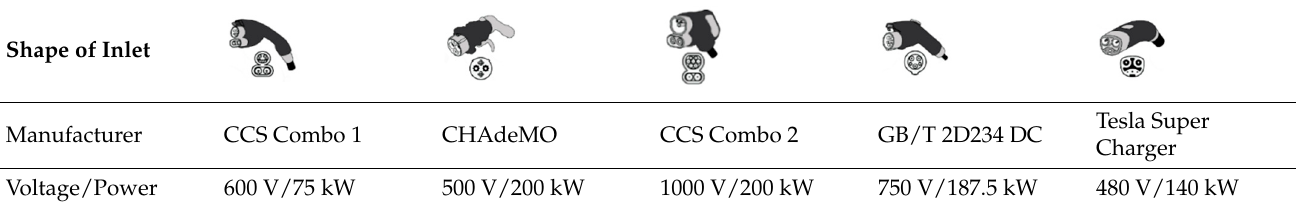
Table 2. The types of XFC charger available in the market [22,23].